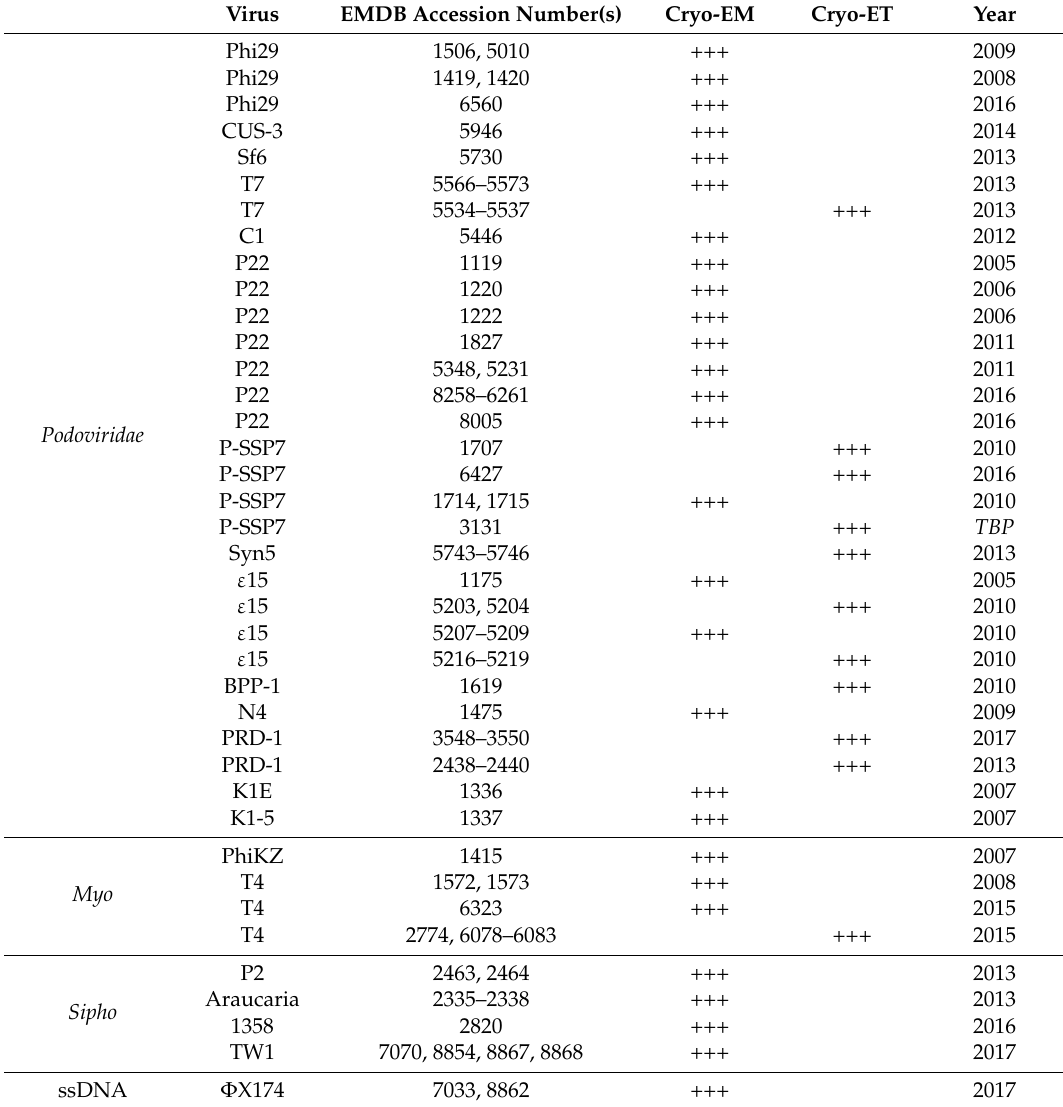
Table 2. Inventory of asymmetric cryo-EM and cryo-electron tomography (cryo-ET) structures of DNA bacteriophages that contain protein complexes that break icosahedral